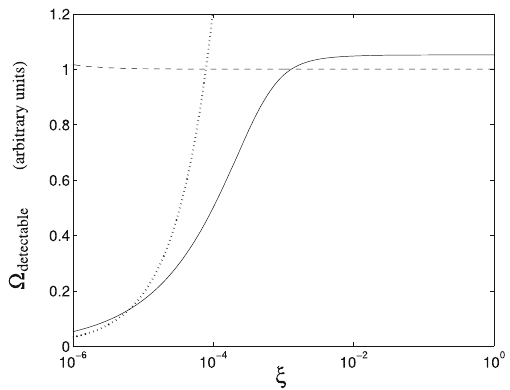
Fig. 58 The minimum detectable value of Ω gw as a function of the duty cycle ξ . The solid line is the theoretical prediction for the Drasco and Flanagan non-Gaussian maximum-likelihood statistic; the dashed line is for the standard Gaussian-stochastic cross-correlation statistic; and the dotted line is for a single- detectorburststatistic.Thenumberofdatapointsusedwas N = 10 9 ,andthefalsealarmandfalsedismissal probabilities were both chosen to equal 0 . 01. Image reproduced with permission from Drasco and Flanagan (2003), copyright by APS